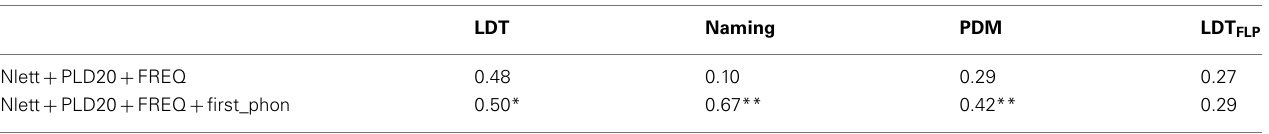
Table 5 | Improvement in percentage of variance explained due to the inclusion of the first phoneme in a multiple regression model with word length (Nlett), PLD20, and word frequency